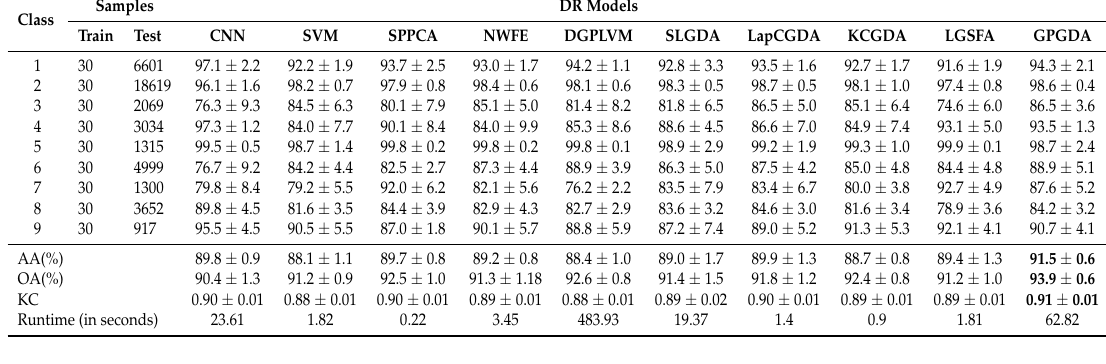
Table 6. Classification results of CNN and different DR methods based on SVM on the University of Pavia data.